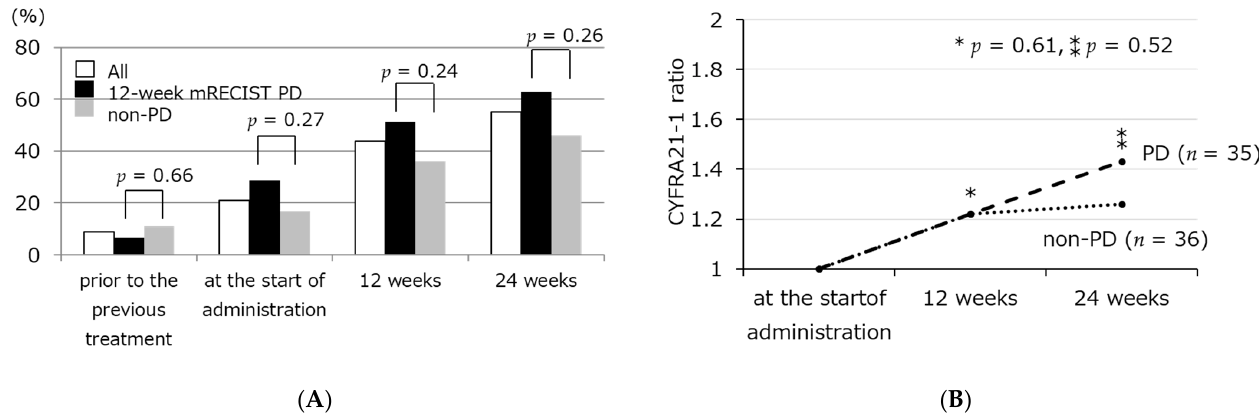
Figure 2. Frequency of CYFRA21-1 ≥ 3.5 ng/mL ( A ), and transition of CYFRA21-1 ratio ( B ) from the start of administration to 24 weeks after administration according to treatment response using mRECIST. * Comparison of PD group and non-PD group at 12 weeks, ** Comparison of PD group and non-PD group at 24 weeks.